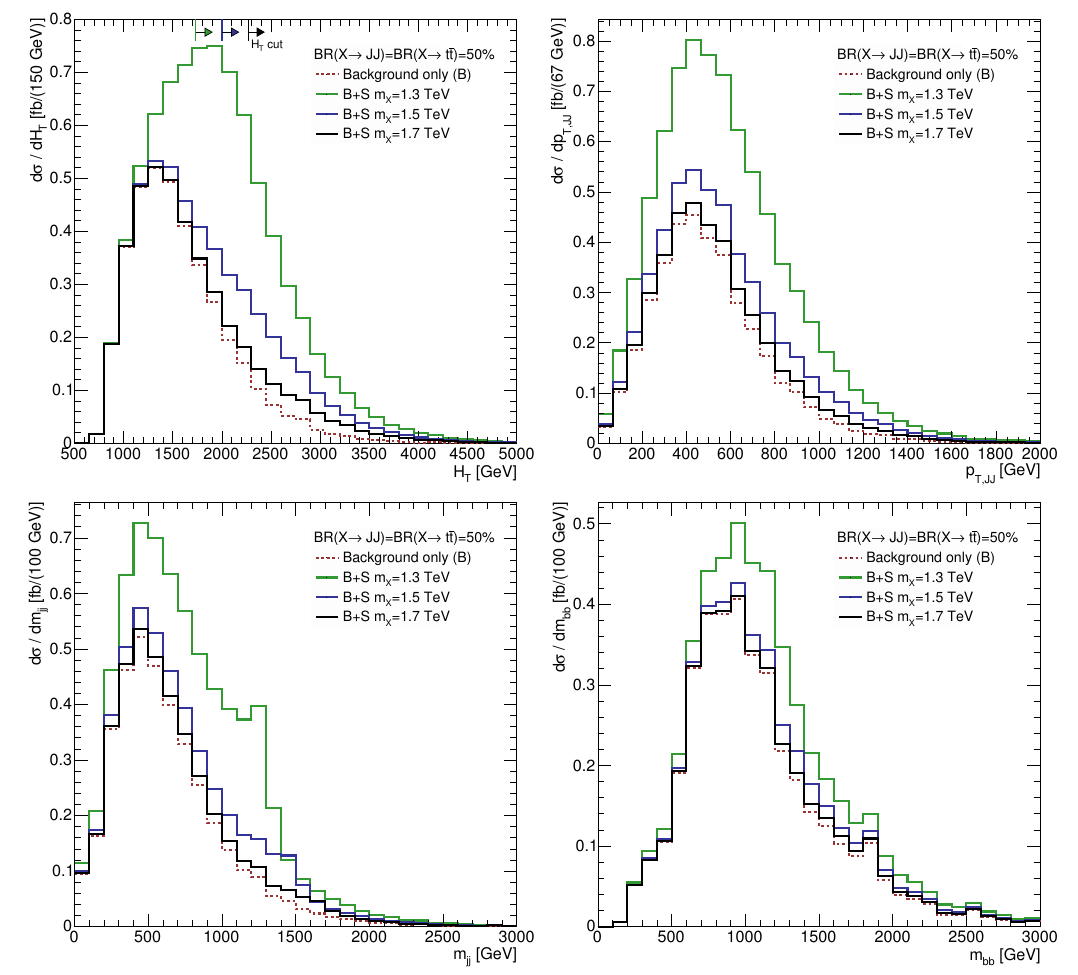
Figure 1 . Di(cid:11)erential distributions in the semi-leptonic analysis for H T (upper left), p T;JJ (upper right), m jj (lower left), and m bb (lower right), where the invariant mass de(cid:12)nitions are described in the main text. We show distributions for the SM t (cid:22) t + jets background (red, dashed), stacked background + m X = 1 : 3 TeV signal (green, solid), background + m X = 1 : 5 TeV signal (blue,